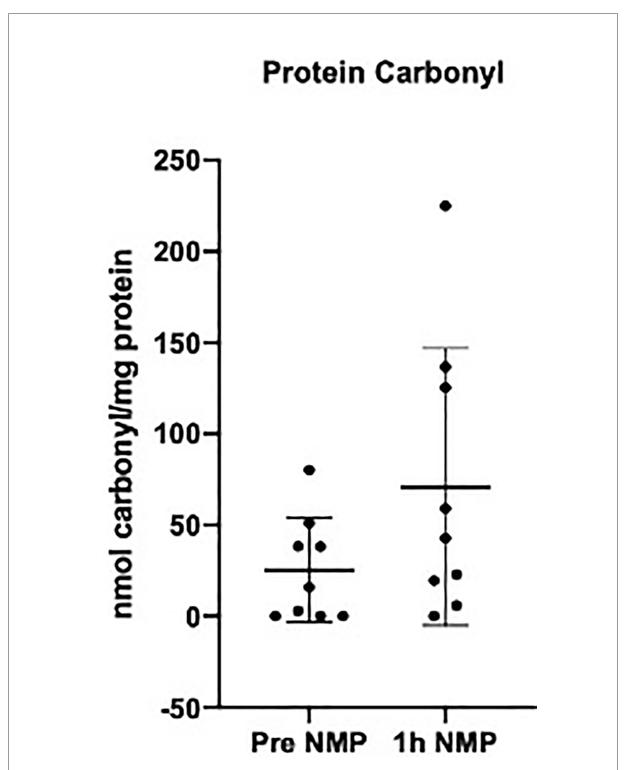
FIGURE 5 | Levels of protein carbonyl quantifying oxidative stress measured in the perfusate pretransplant and post 1h NMP in a series of human kidneys that were rejected for transplant and offered for research. Data presented as mean (SD).